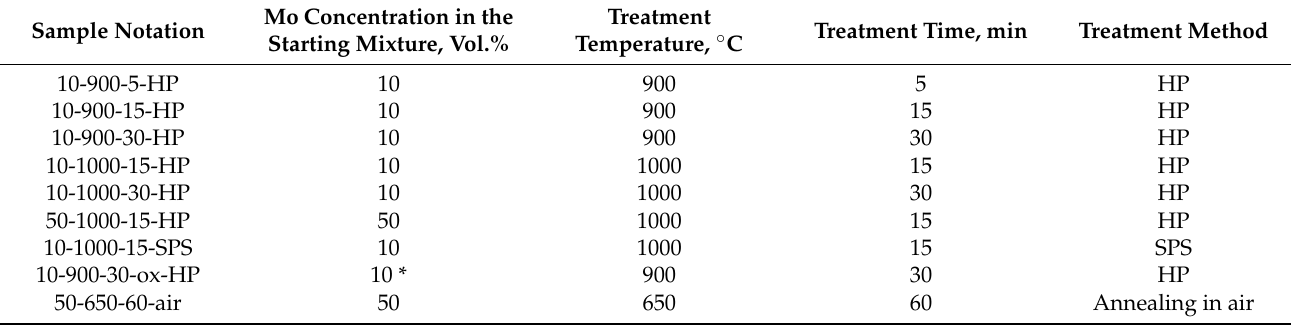
Table 1. Synthesis conditions and sample